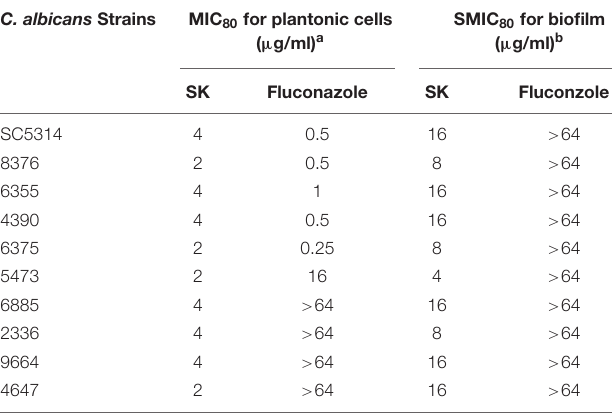
TABLE 2 | Effects of shikonin and fluconazole against Candida albicans